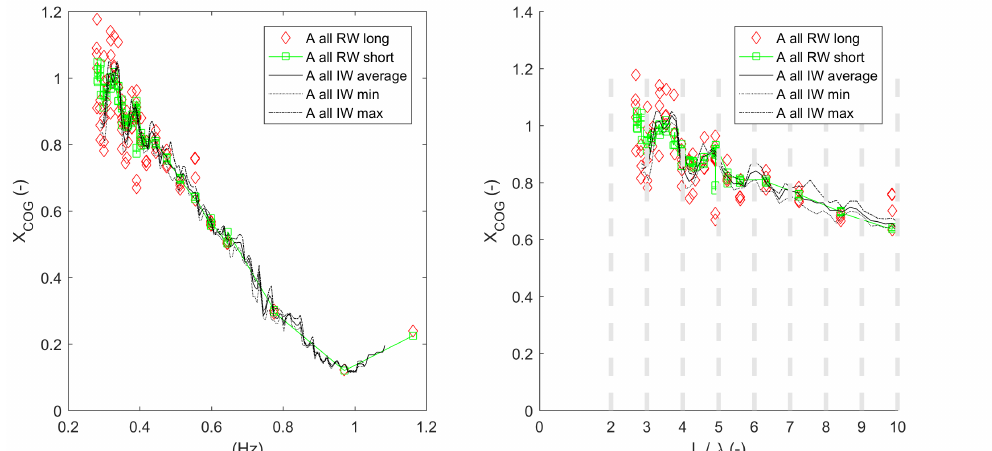
Figure 18. Surge RAOs from regular and irregular waves in basin A (as function of frequency ( left ) and ratio of basin’s length by wave length ( right ).